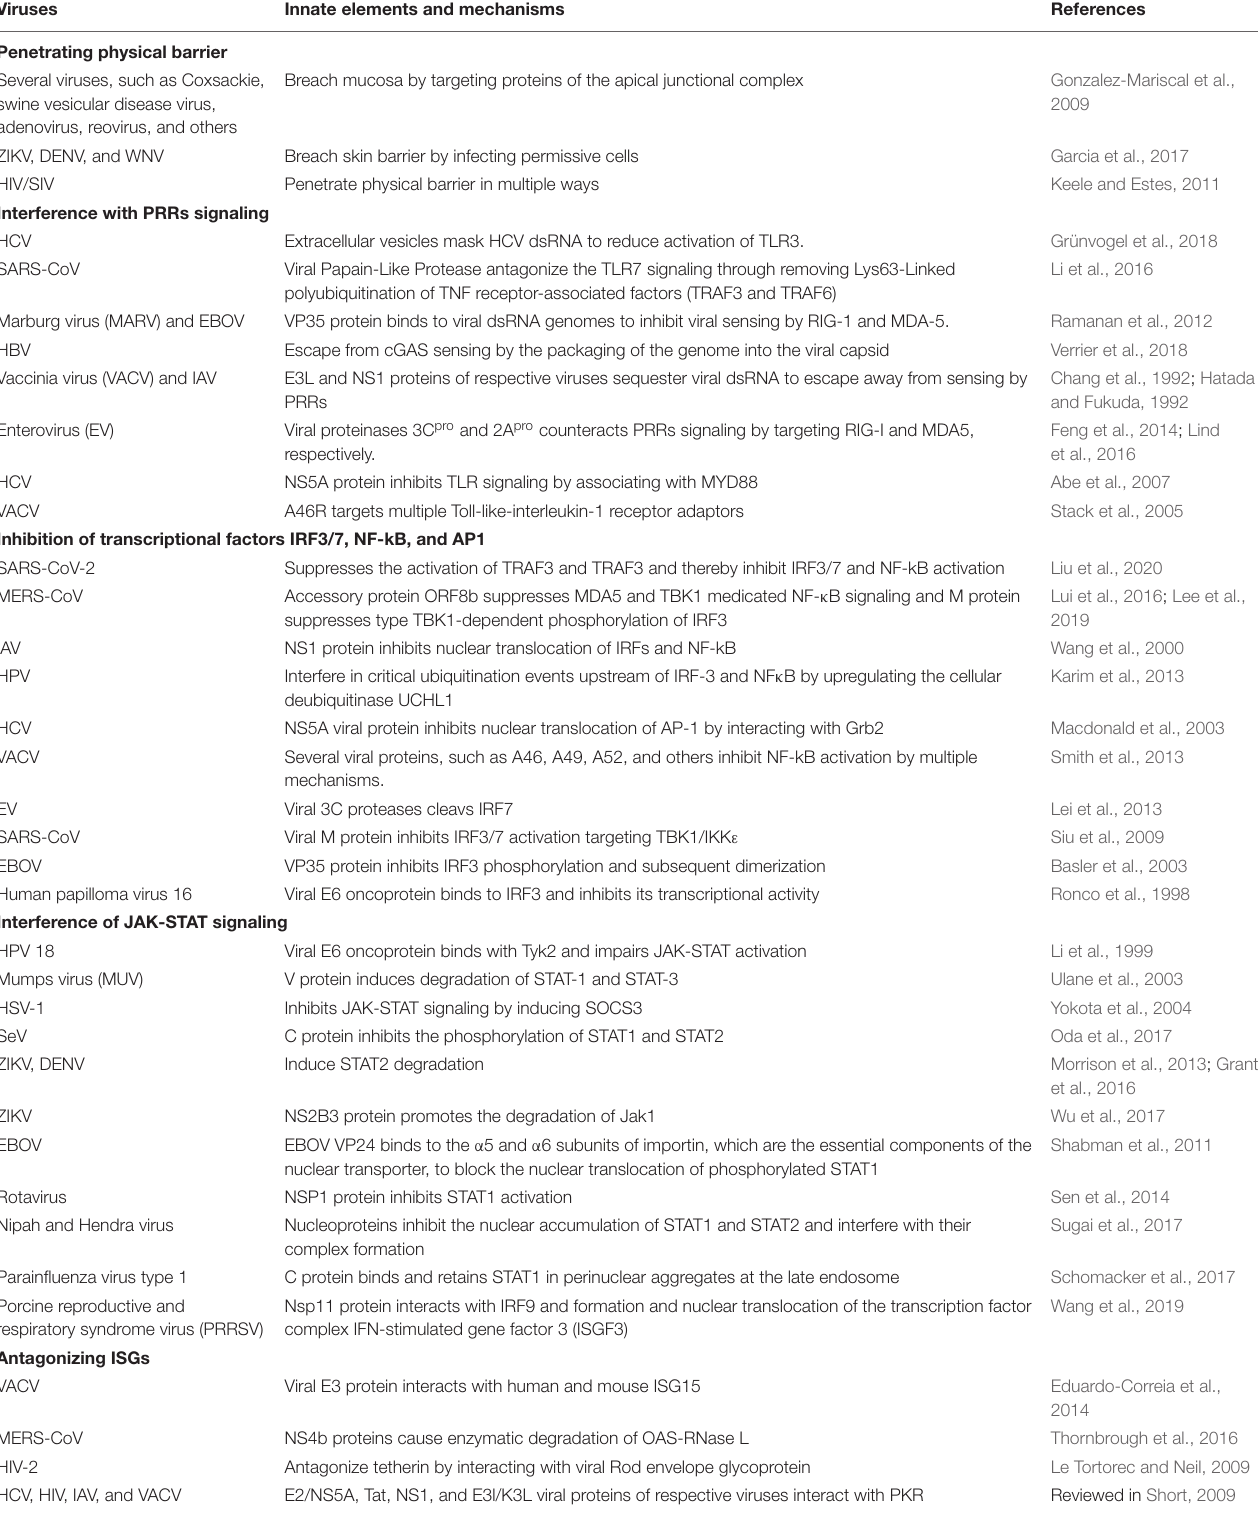
TABLE 1 | Representative immune escape